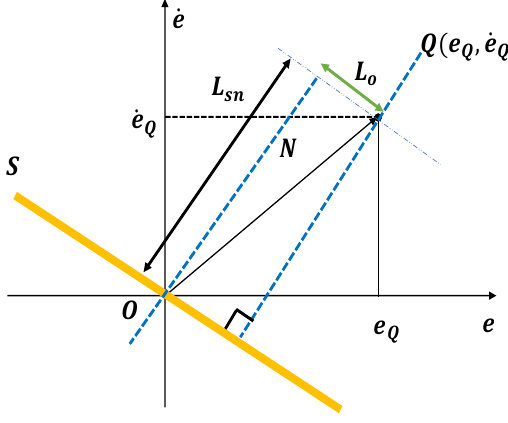
Figure 2. Vectoral distance between 𝐿 𝑠𝑛 and 𝐿 𝑜 . Table 2. Rule base for bounded-layer fuzzy-based